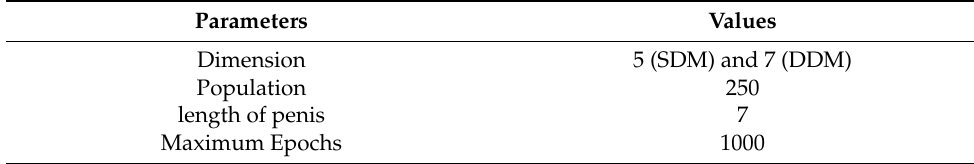
Table 1. Proposed BMO algorithm parameters